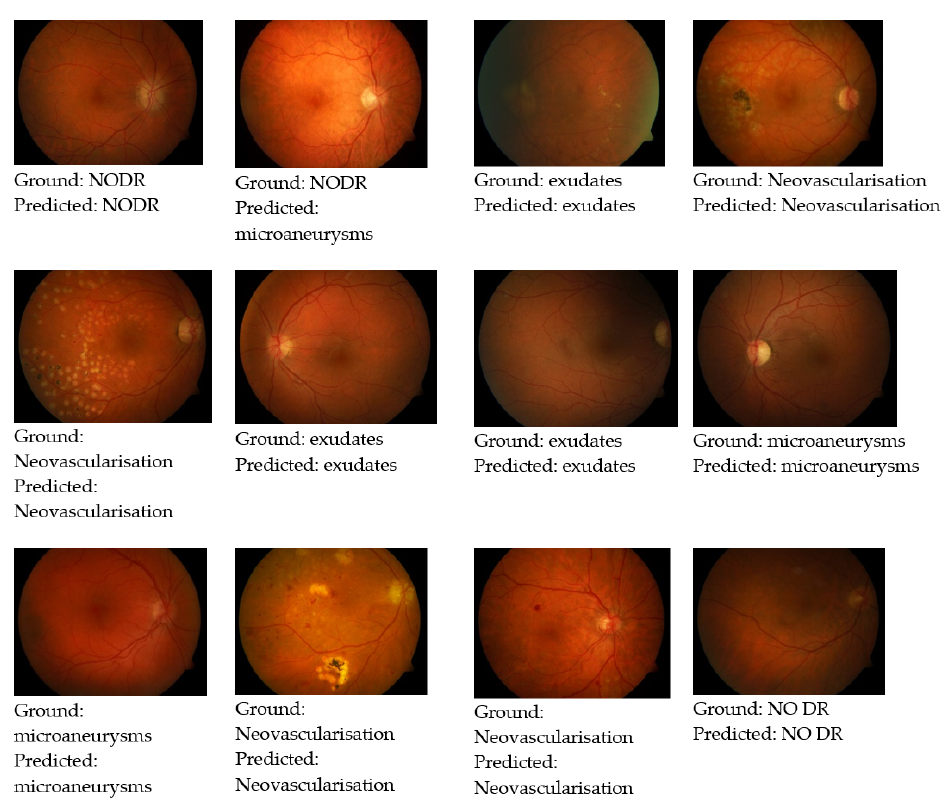
Figure 5. Test images with ground truth with improved CNN predictions.